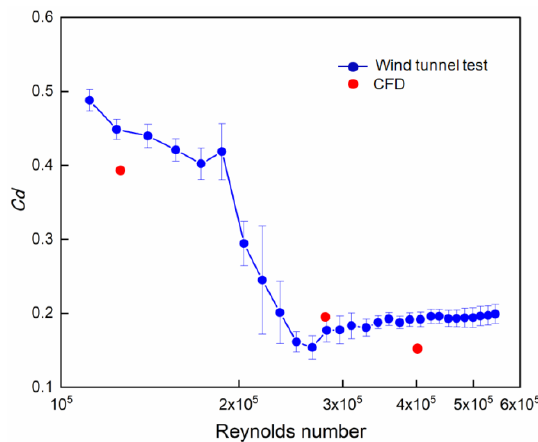
Figure 3. Comparison of the drag force coefficients of a nonspinning ball determined from CFD analyses and wind tunnel tests (the error bars indicate the standard deviation of Cd ).